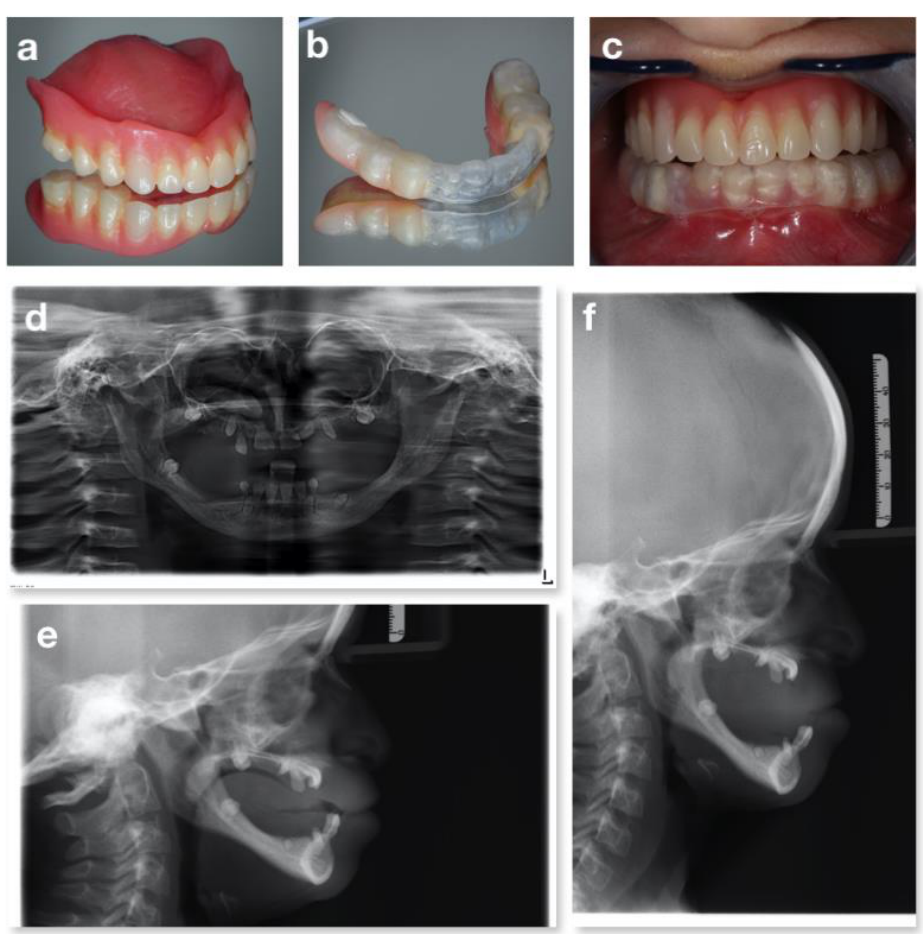
(Figure 8d) confirmed the oligodontia, delayed eruption and teeth shape anomalies, with short and thin roots (rizomicria). The condyles appeared dysmorphic and flattened.